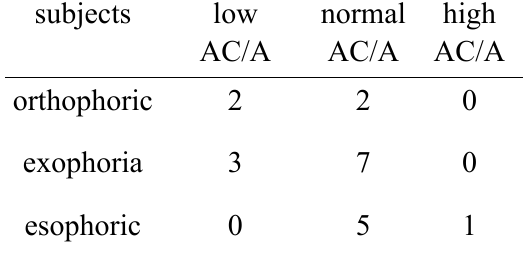
Table 6: Distribution of AC/A ratio subjects